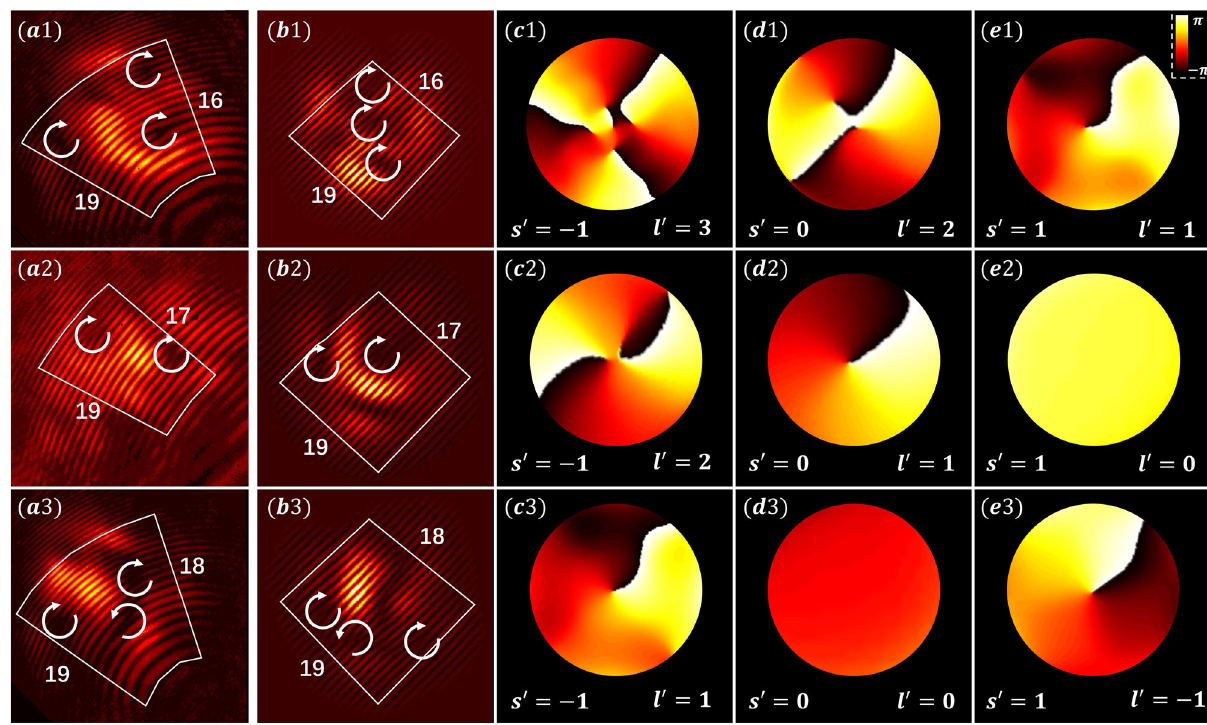
Fig. 5 Decomposed pseudospin components in an angular-momentum-conserved Lieb lattice. Experiment and simluation results for initial excitations of the pseudospin states s = 0 in (a1 – e1), s = 1 in (a2 – e2) and s = − 1 in (a3 – e3) with four input beams of topological charge l = 1. Output interfrograms from ( a ) experiment and ( b ) simulation show different topological charge conversions under different excitation conditions. ( c – e ) show output phase structure of the probe beam numerically decomposed for each pseudospin component s ′ , where corresponding output vorticity l ′ in each component has been identi fi ed. In all cases, each pseudospin component obeys Eq. (3).